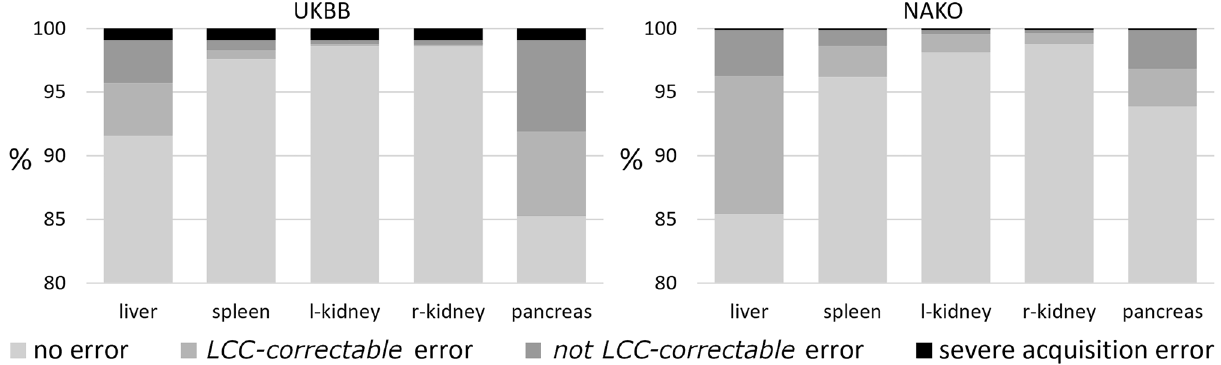
Figure 2. Frequency of segmentation error categories and severe acquisition errors (%) per organ for UKBB (left) and NAKO (right). LCC = largest connected component.